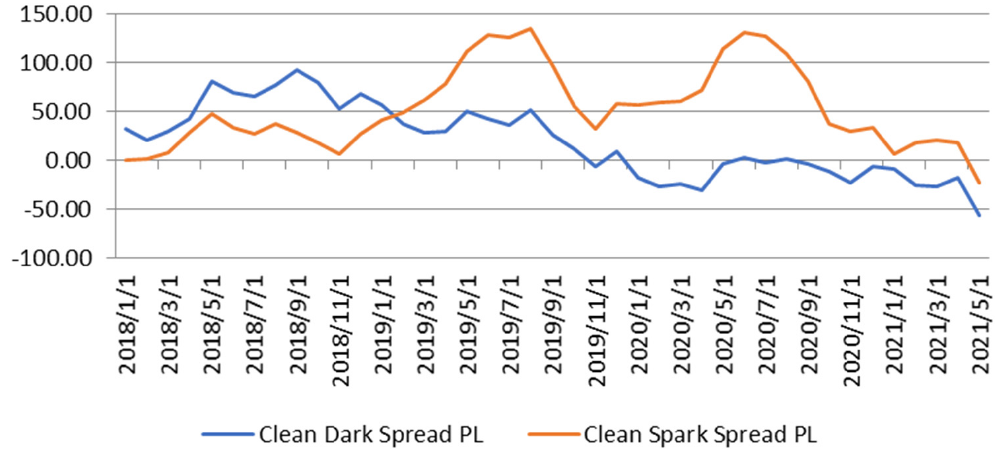
Figure 4. CDS and CSS in Poland, 2018–2021. Source: Society for Energy Trading, Electricity And Gas Market In Poland—state as of 31 March 2021, SET Report, p. 363 [33].